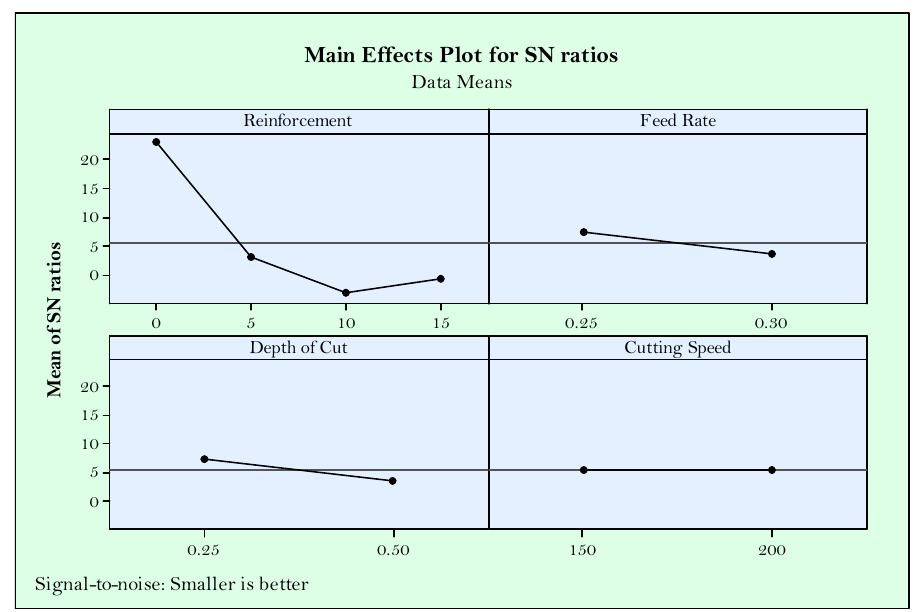
Figure 6. Main effect plots for S/N ratios of flank wear.